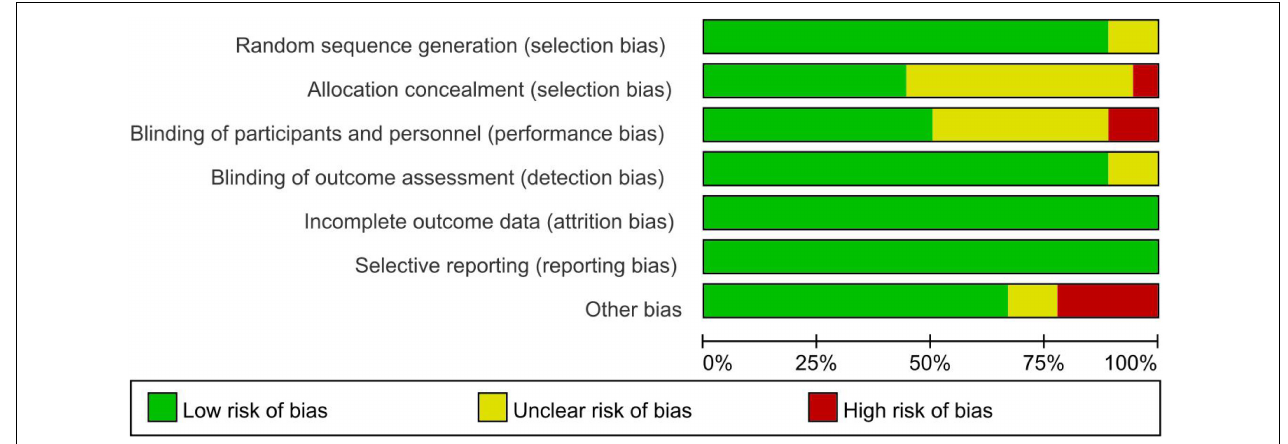
FIGURE 2 | Graph of the risk of bias: percentage across all included